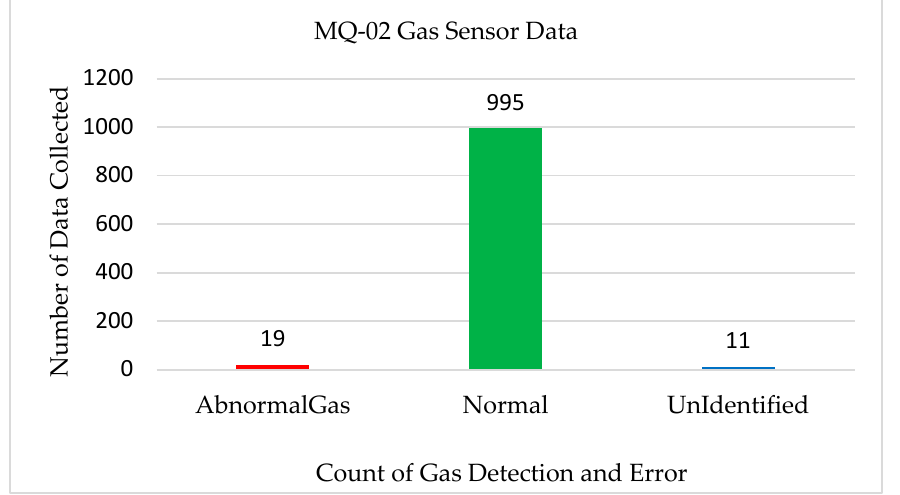
Figure 7. Test results for the MQ-2 gas sensor.